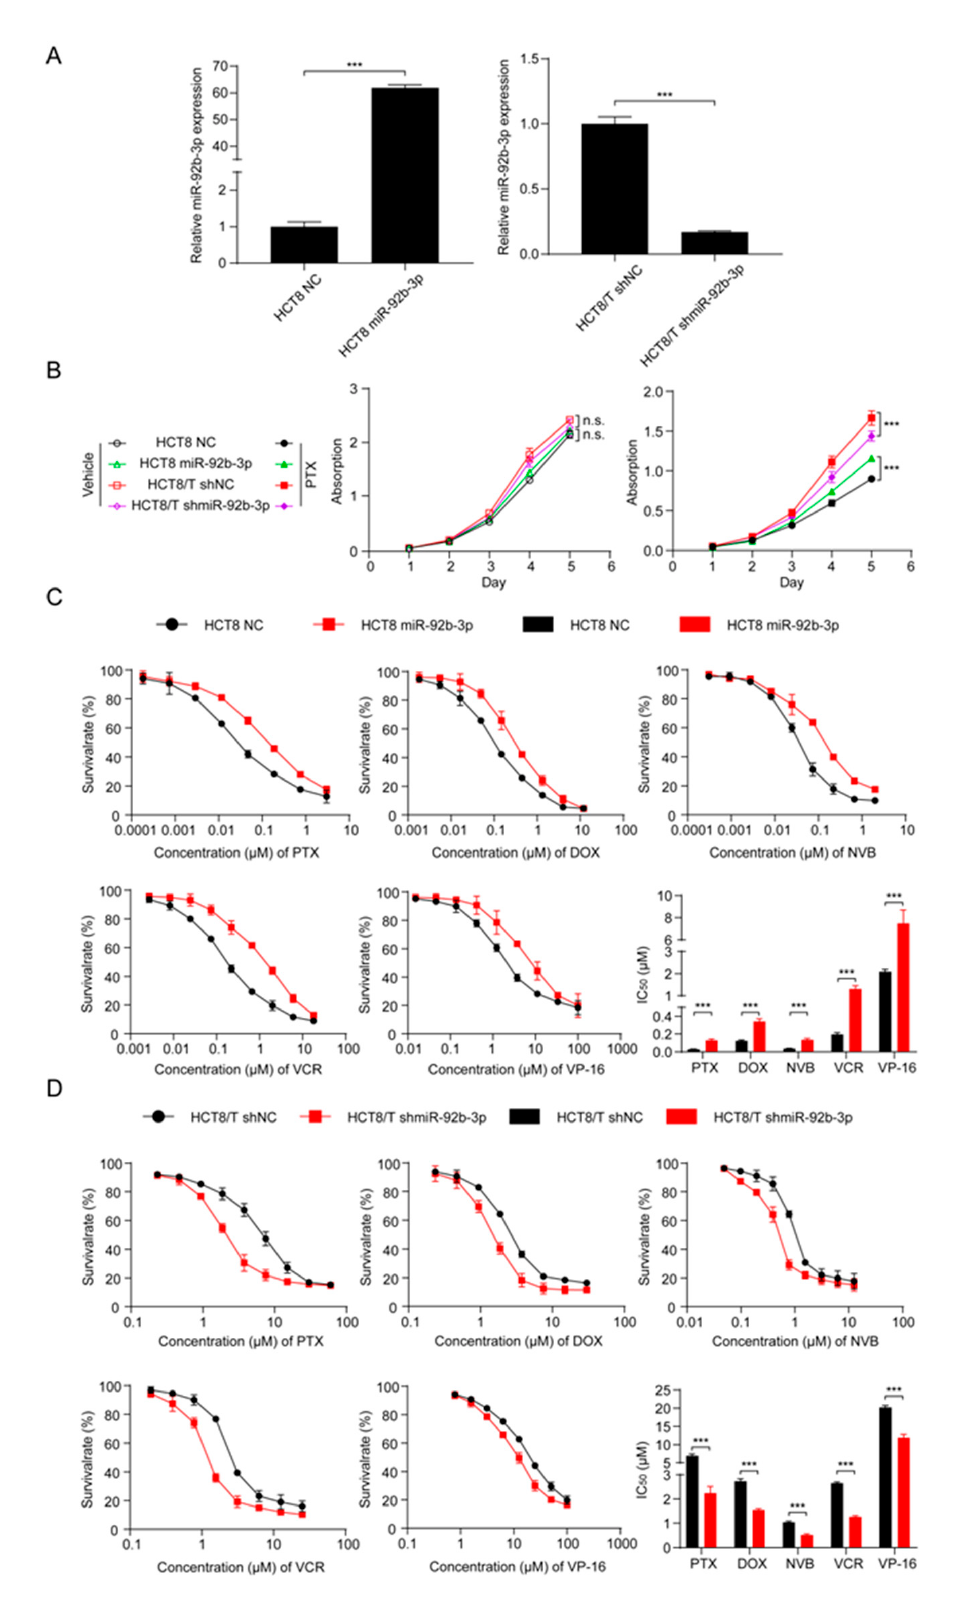
Figure 2. miR-92b-3p maintains the cell viability and promotes the chemoresistance of HCT8 and HCT8/T cells to chemotherapeutic drugs. ( A ) qRT-PCR analysis of the efficiency of miR-92b-3p overexpression in HCT8 cells and knockdown in HCT8/T cells. ( B ) miR-92b-3p maintains the cell viability in the presence of PTX. Cells were treated with or without 10 nM PTX for different time and then subjected to CCK8 assay. ( C ) Overexpression of miR-92b-3p desensitized HCT8 cells to chemotherapeutic drugs, and ( D ) Knockdown of miR-92b-3p resensitized HCT8/T cells to chemotherapeutic agents. Cells were treated with drugs at gradient concentrations for 72 h, then cell survival curves and IC 50 values of multiple chemo- therapeutic drugs were determined by CCK8 assay. All experiments above were repeated three or more times inde- pendently and values are shown as mean ± SD. *** p < 0.001.